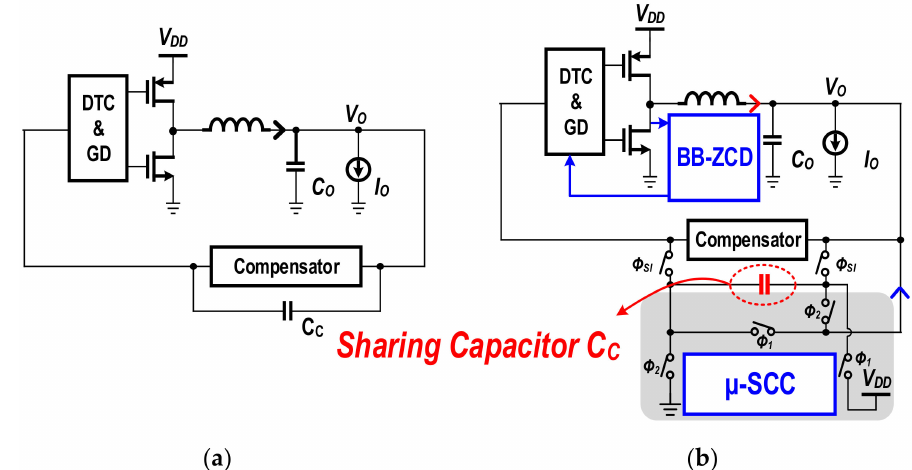
Figure 2. ( a ) Conventional dc-dc buck converter and ( b ) the proposed triple-mode switched inductor- capacitor (SIC) dc-dc buck converter with a reusable flying capacitor and a bang-bang zero-current